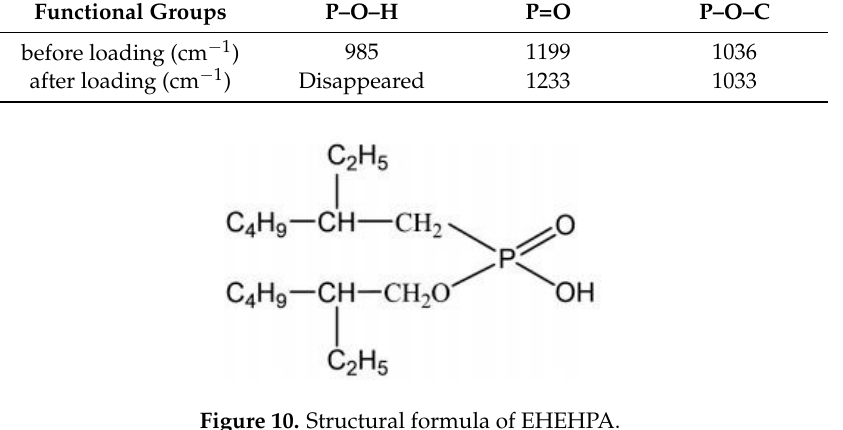
Figure 10. Structural formula of EHEHPA.